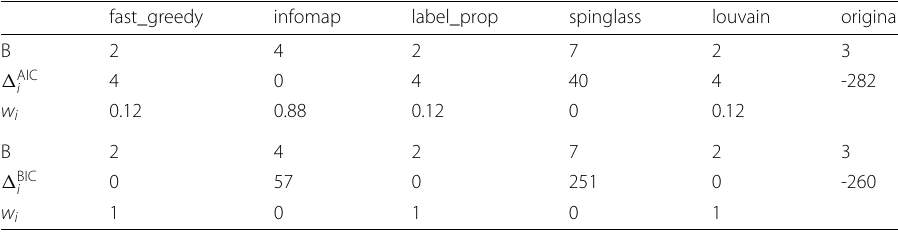
Table 4 Comparison of the goodness-of-fit of 5 different block structures detected by five different community detection algorithms fast_greedy infomap